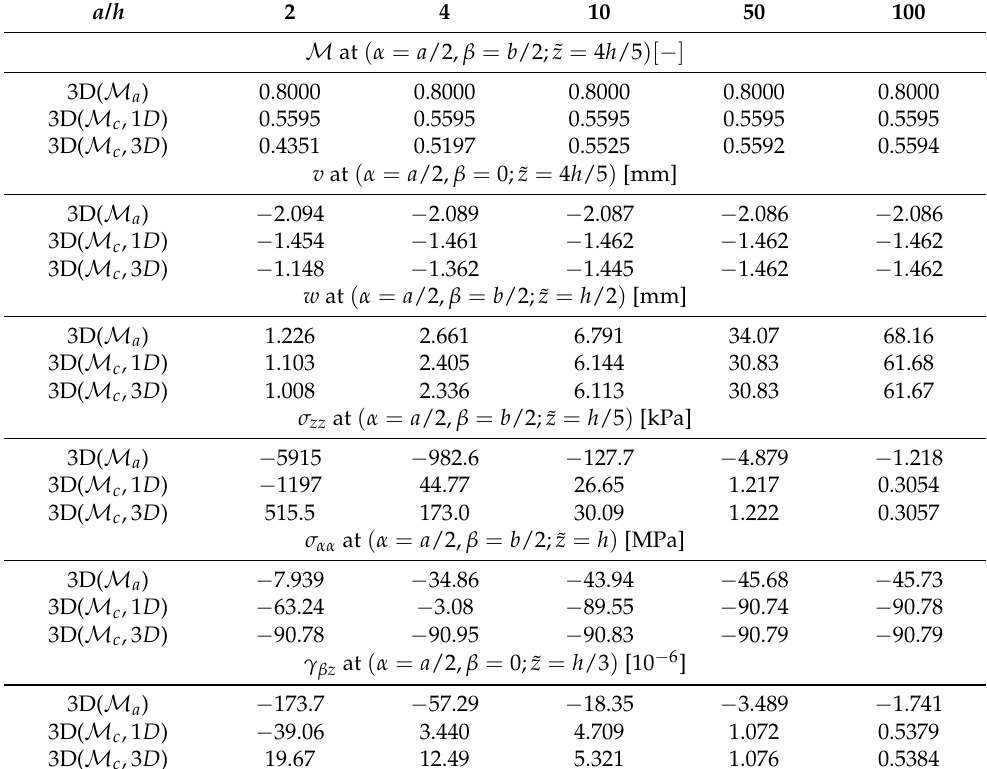
Table 5. First benchmark: square plate with a single FGM layer subject to an external moisture content applied to the top and bottom surfaces. The results of all the 3D models consider N = 3 and NL =